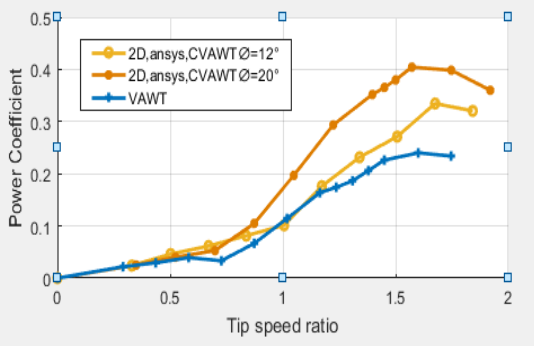
Fig. 7. Velocity distribution along the convergent duct inlet angle 12 . °